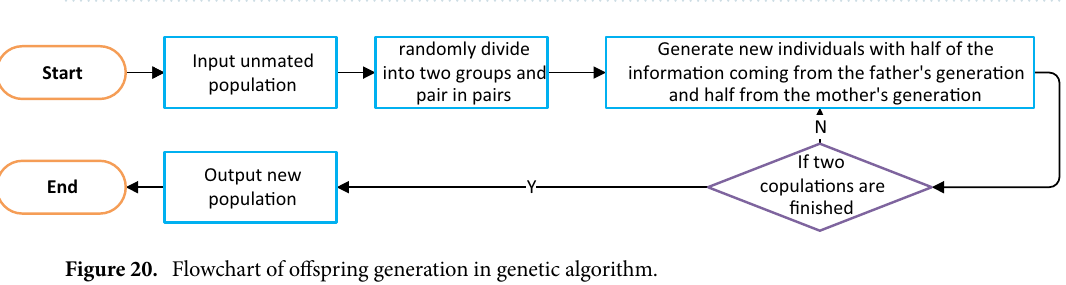
Figure 19. Flowchart of optimal solution function of genetic algorithm.